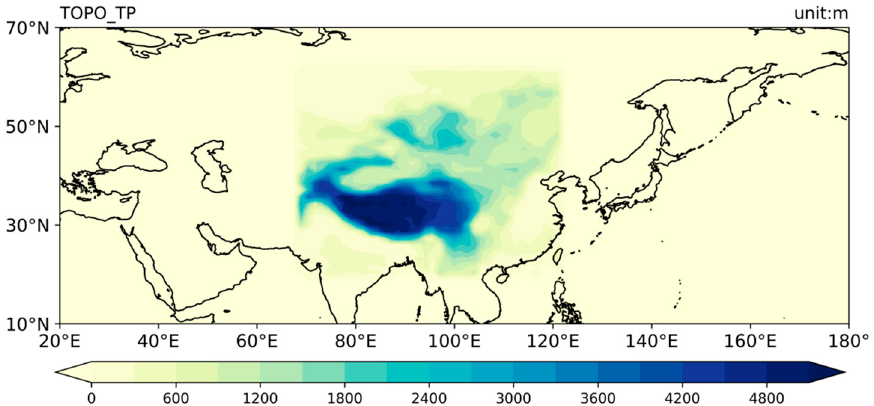
Figure 1. Topographical configuration (unit: m) for the experiment with the Tibetan Plateau and its surrounding areas.